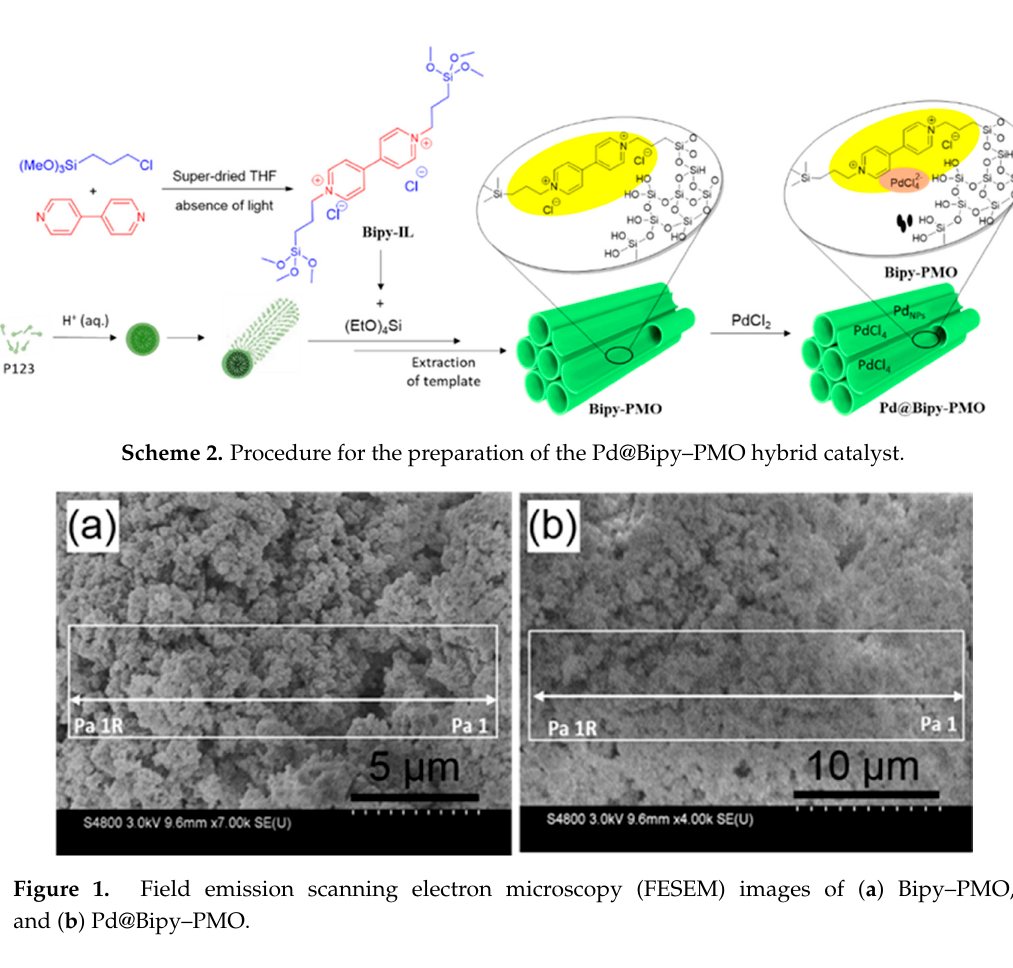
Figure 1. Field emission scanning electron microscopy (FESEM) images of ( a ) Bipy – PMO, and ( b ) Pd@Bipy – PMO.